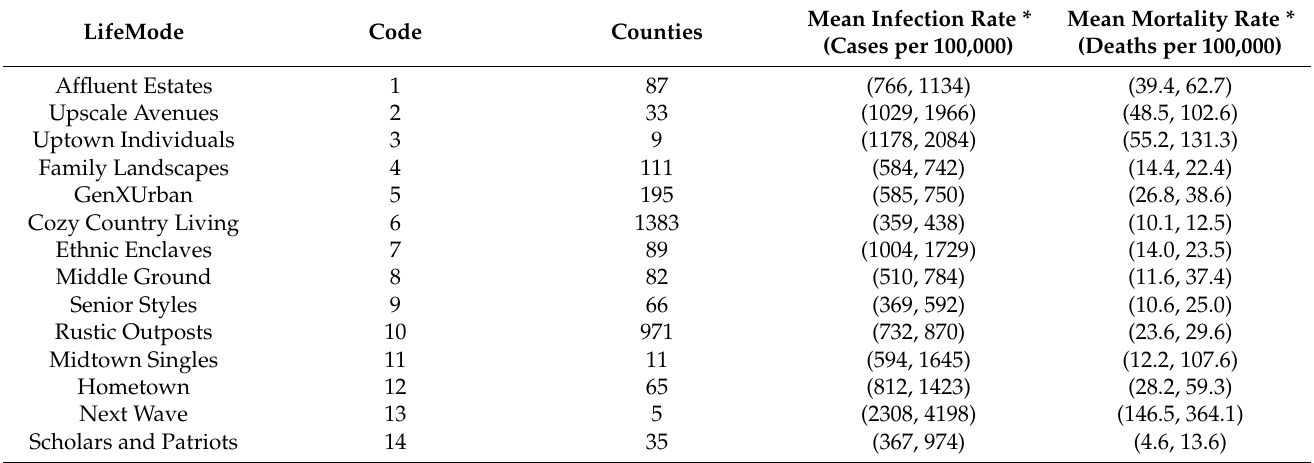
Figure 6. High- and low-risk LifeModes from 1 April to 1 July 2020. Table 4. Mean case rate by LifeMode.